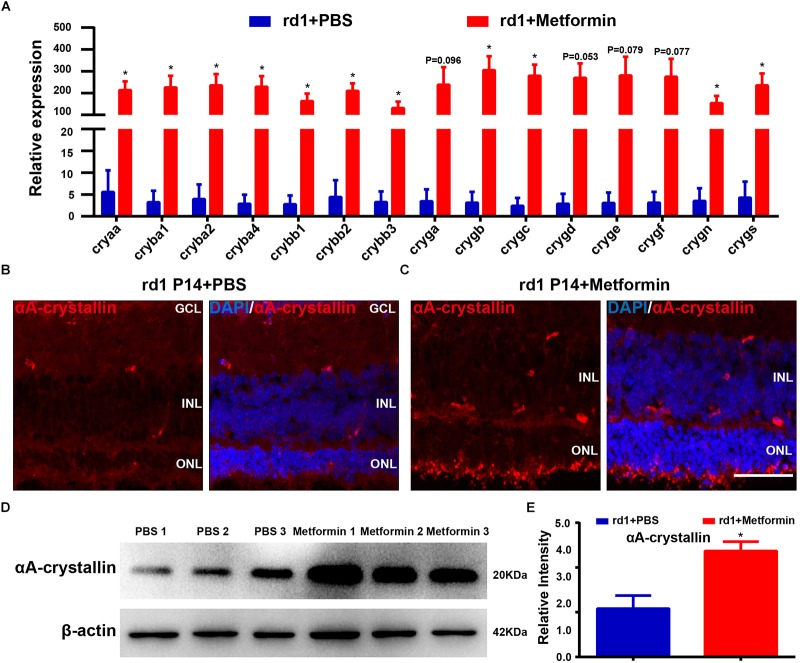
Quantitative RT-PCR validation of core genes identified in the RNA-Seq analysis. (A) Real-time PCR analysis of the expression of crystallin. Blue: PBS-treated group. Red: metformin-treated group. Representative images of immunofluorescence for specific markers, including αA-crystallin cells (red) and DAPI (blue), in the mouse retina. (B) Rd1 mice treated with PBS at P14; (C) rd1 mice treated with metformin at P14. (D) Representative Western blot bands for αA-crystallin versus β-actin. (E) Comparison of protein grayscale semiquantitative analyses between the control group and the Met group. n = 3 samples per group. GCL, retinal ganglion cell layer; INL, inner nuclear layer; ONL, outer nuclear layer. Data are presented as the mean ± SEM. NS, no significant difference. ∗p < 0.05, ∗∗P < 0.01. Scale bar: 50 μm.